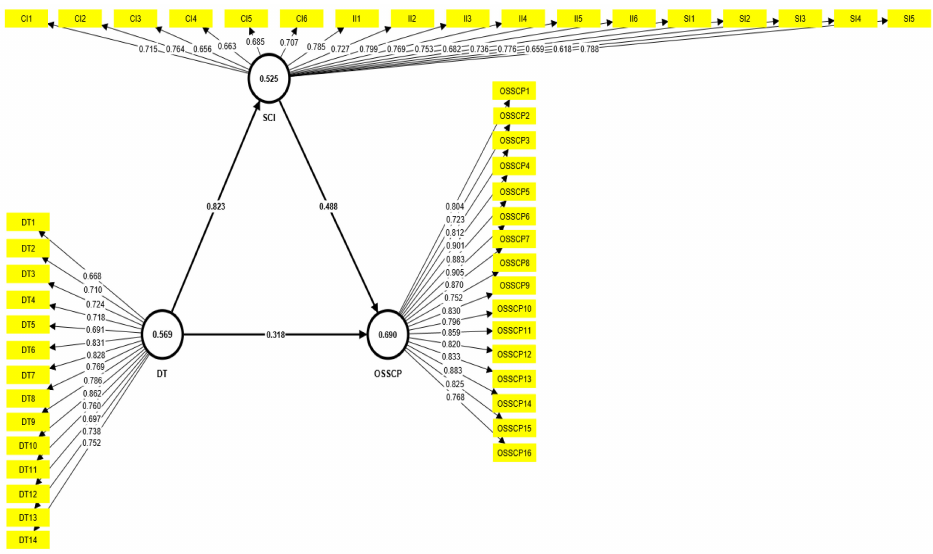
Figure 2. The measurement